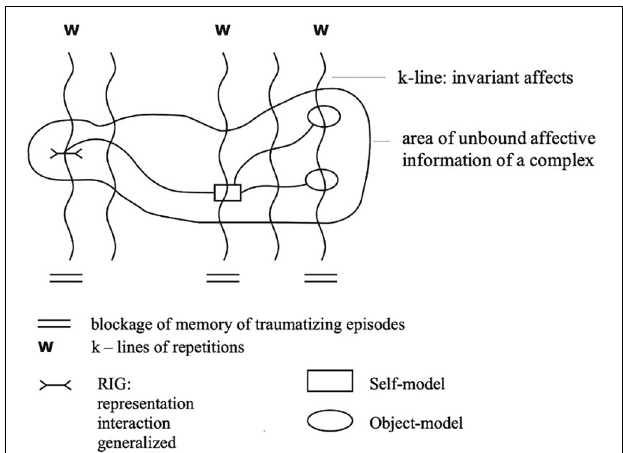
FIGURE 1 | Memory Model of conflictual complexes adapted from Moser and von Zeppelin (1996). W, repetitions (i.e., Wiederholungen) caused by invariant affects, which are not yet bound in the personal-historical life narrative of the individual; areas of unbound affective information: complexes consisting of self- and object-models and generalized interaction representation (RIG), which are grouped by k-lines of invariant affects, causing blockage of memory of closely related traumatizing